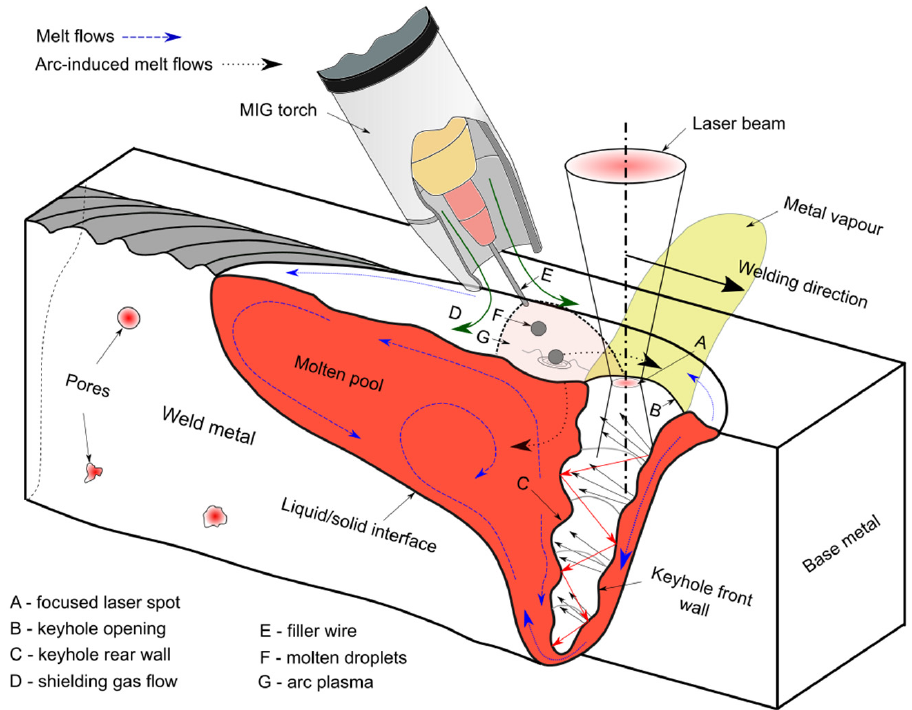
Figure 8. Representation of LAHW in paraxial configuration with leading laser/trailing arc and their melt flow behaviours. Melt flows are based on [30,38,40,50,59,99,114–129]. The advantages of the LAHW are [30,40,50,99,130]: